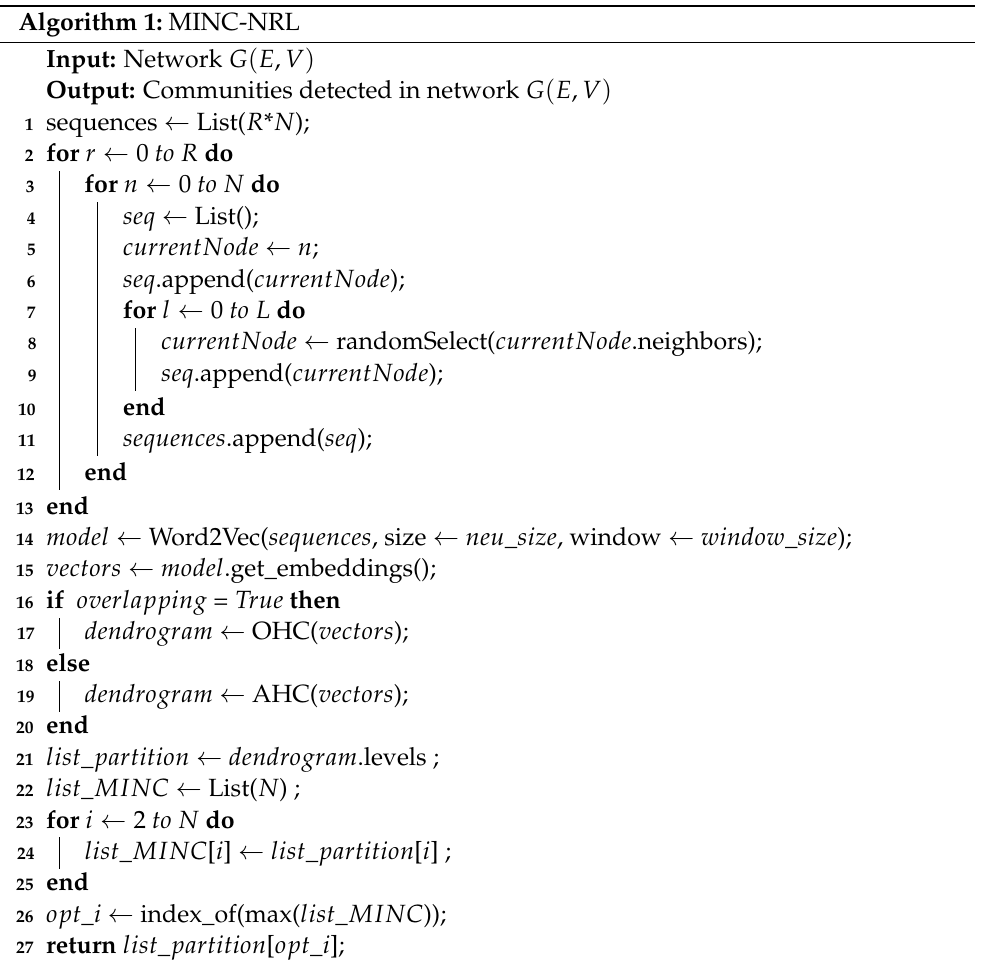
Figure 5. MINC value of community evolution process generated from Polbooks. The pseudo-codes in Algorithm 1 gives a brief description of